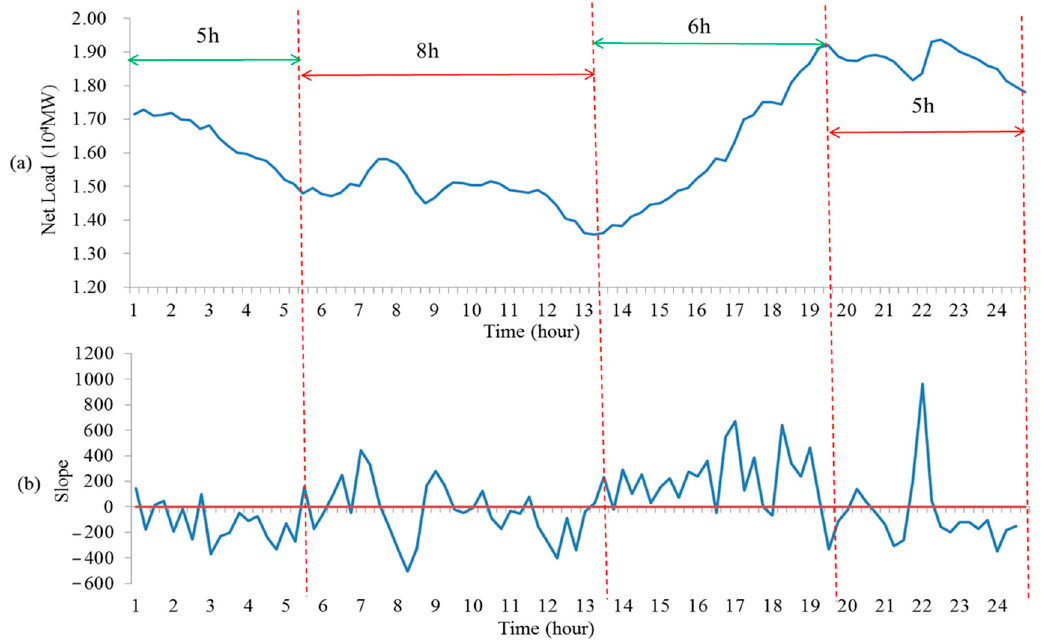
Figure 5. Net load curve of the provincial power grid ( a ) and the slope of net load ( b ).